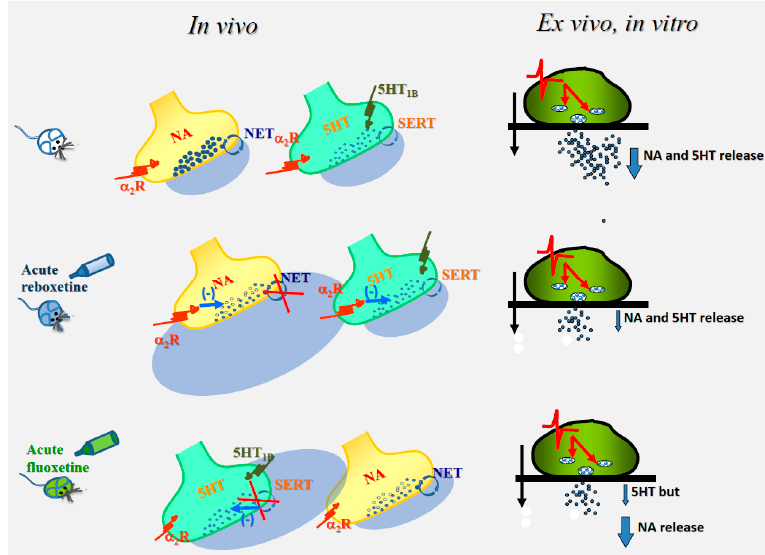
Figure 1. The cartoon describes the mechanisms proposed to trigger the “ex-vivo, in vitro” modifications of noradrenaline and serotonin exocytosis (blue arrow) in hippocampal synaptosomes isolated from animals acutely treated with reboxetine (middle) or fluoxetine (bottom) when compared to control condition (untreated animals, top). Noradrenergic terminals possess α 2 autoreceptors, while serotonergic receptors possess both 5HT 1B autoreceptors and α 2 heteroreceptors. It is proposed that the “in vivo” activation of both the α 2 autoreceptors and the α 2 heteroreceptors that would follow the acute administration of reboxetine might account for the reduced exocytosis of both noradrenaline and serotonin, while, based on notion that noradrenergic terminals do not possess serotonergic release-regulating heteroreceptors (left side of the Figure), serotonin-induced activation of serotonergic receptors in fluoxetine-treated animals only can occur at serotonergic terminals. The functional adaptations elicited by the “in vivo” activation of the presynaptic release-regulating receptors are retained by isolated synaptosomes and emerge subsequently in “in vitro” studies as changes in release efficiency (right side of the panel). Reboxetine and fluoxetine block the NA transporter (NET) and the 5HT transporter (SERT, circular arrow), increasing NA and 5HT bioavailability in the synaptic cleft. Synaptosomes were labelled with radioactive tracers and superfused with superfusion medium (black arrow). Synaptosomes were transiently (90 s) exposed to a depolarizing stimulus (the red line indicating the change in membrane potential) that causes vesicular exocytosis (red arrow) of transmitters (black